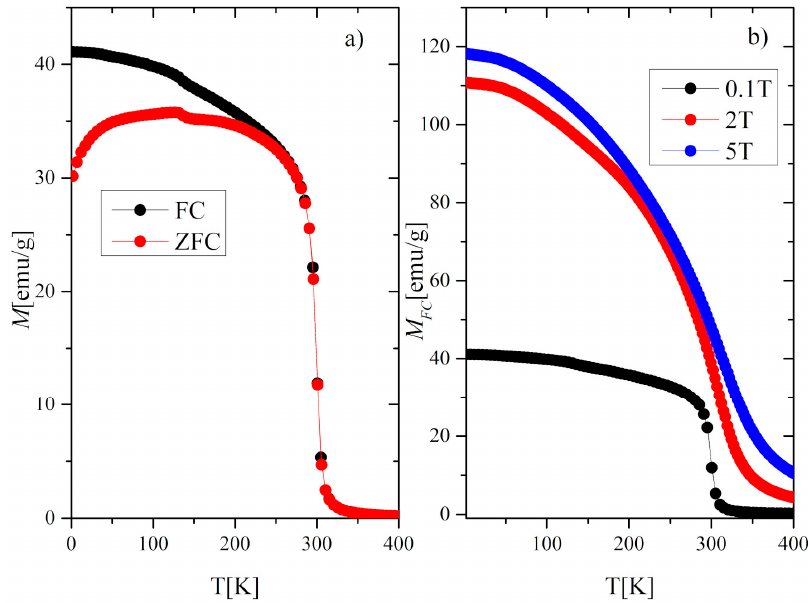
Figure 2. ( a ) Magnetization M versus temperature in the FC and ZFC mode at a magnetic field of 0.1 T, ( b ) Magnetization in the FC mode at 0.1, 2, and 5 T.